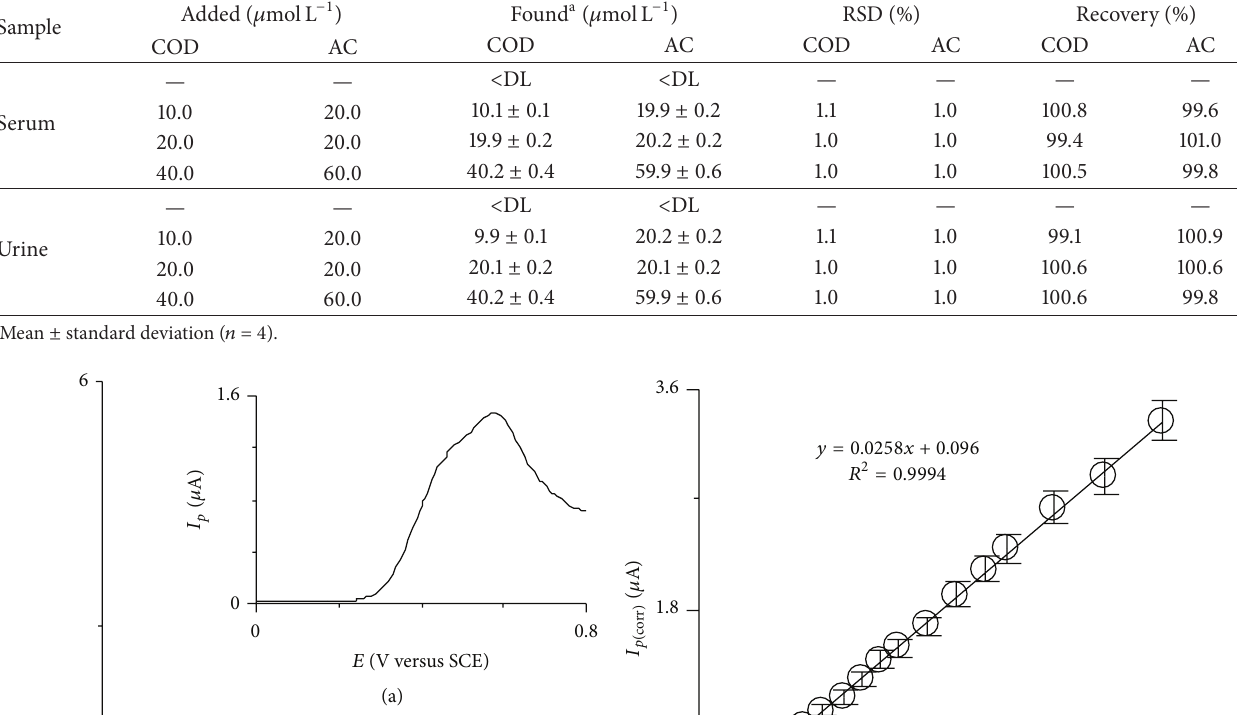
Table 3: Determination of codeine in human urine and serum samples using HTP-MWCNT-CPE.